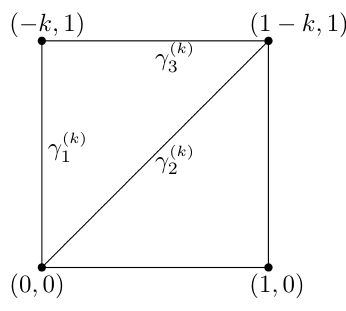
Figure 10 . Triangulation after k flips of Π γ 1 ,γ 2